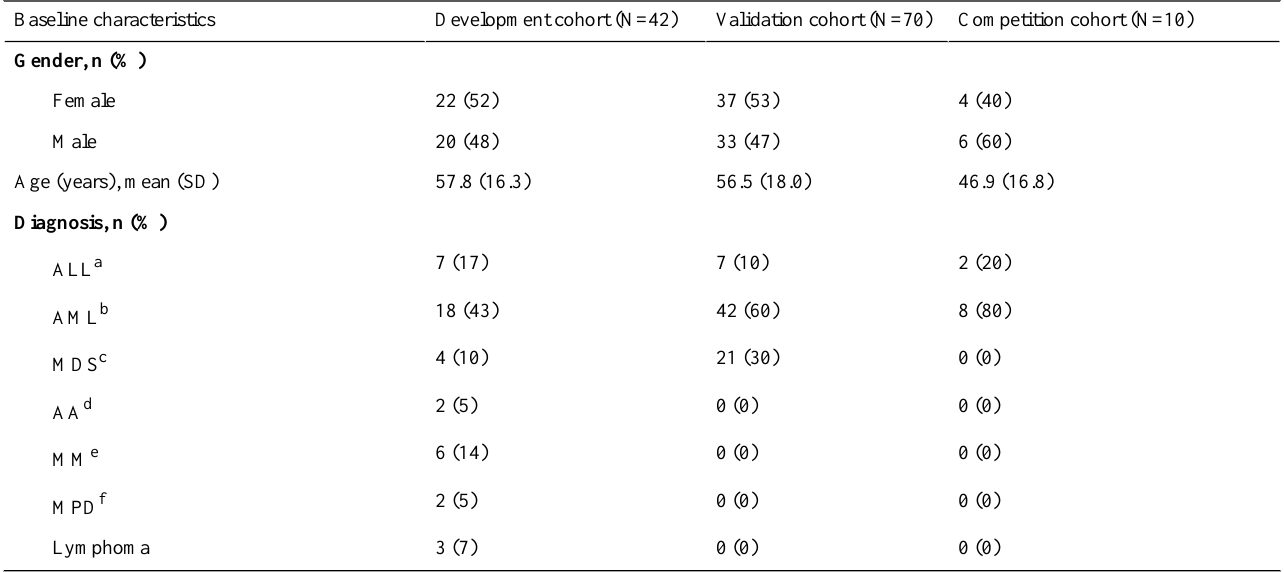
Table 1. Baseline characteristics in three study